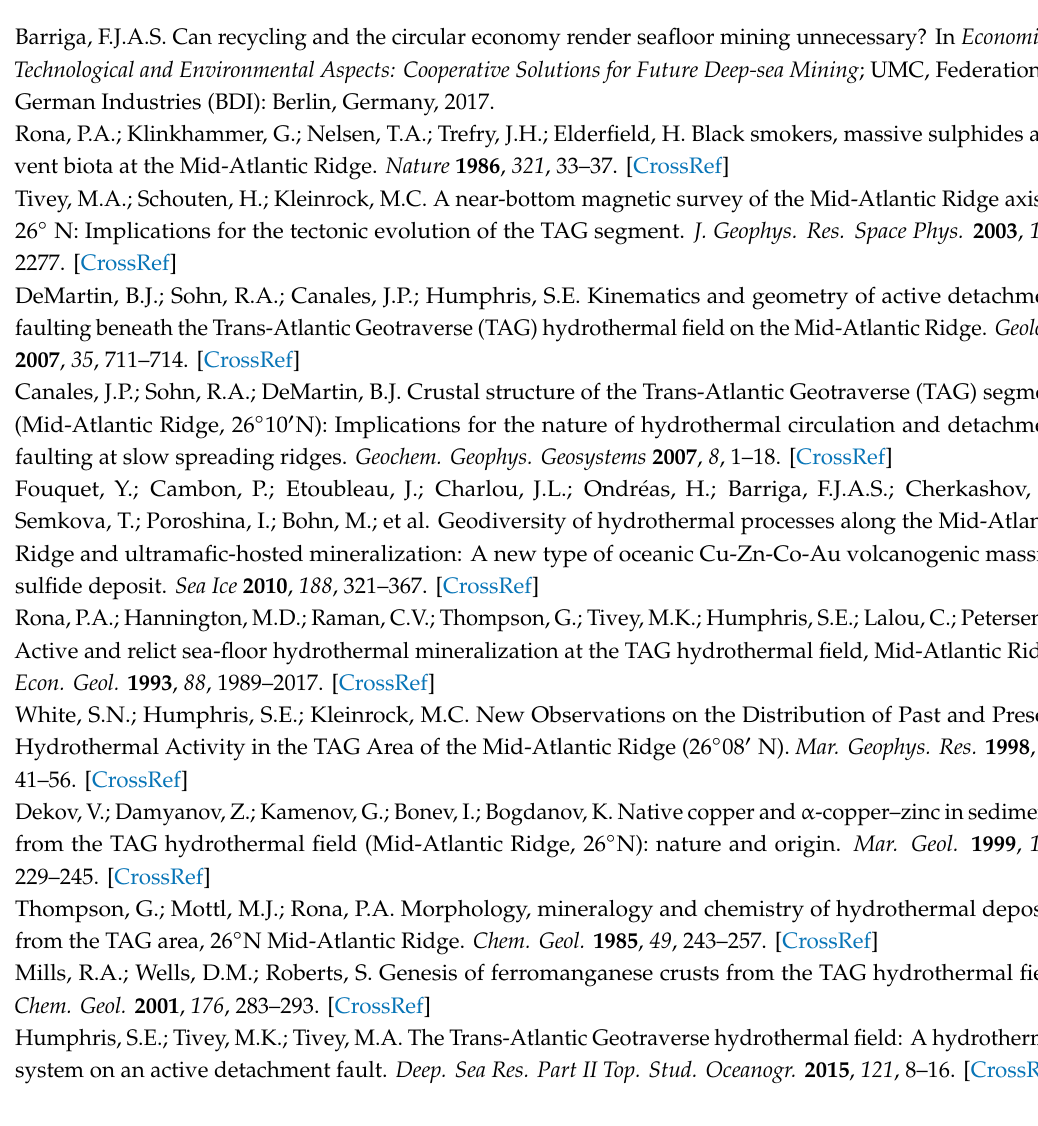
Figure S1: XRD-pattern (and identified mineral phases) of the sample GC-627 / B-151; Figure S2. XRD-pattern (and identified mineral phases) of the sample GC-627 / A-226; Figure S3. XRD-pattern (and identified mineral phases) of the sample GC-682 /